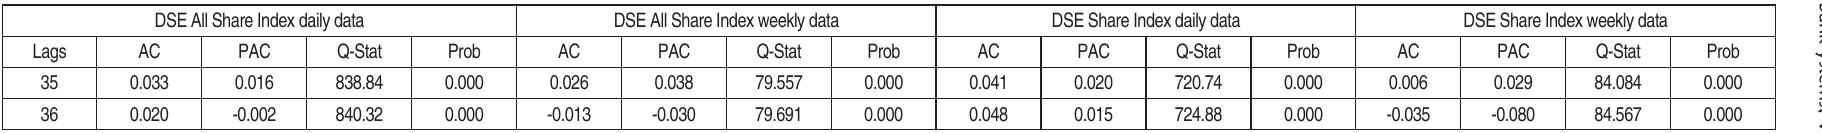
Table 2 (cont.). Results of the serial correlation